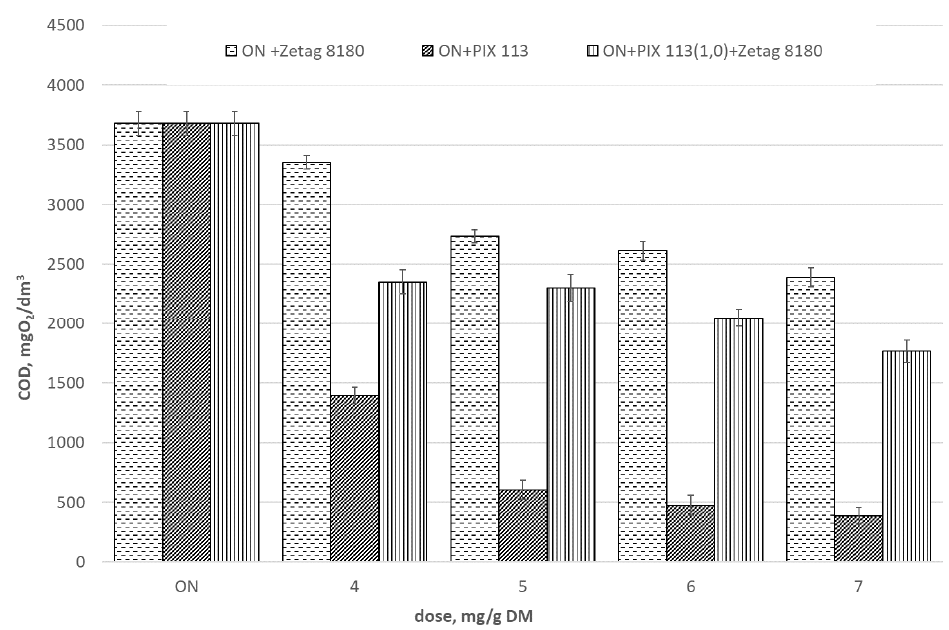
Figure 8. COD changes in filtrate after sludge dewatering. Sludge sonicated (A 1 = 15.25 µm) and prepared with selected chemical reagents.